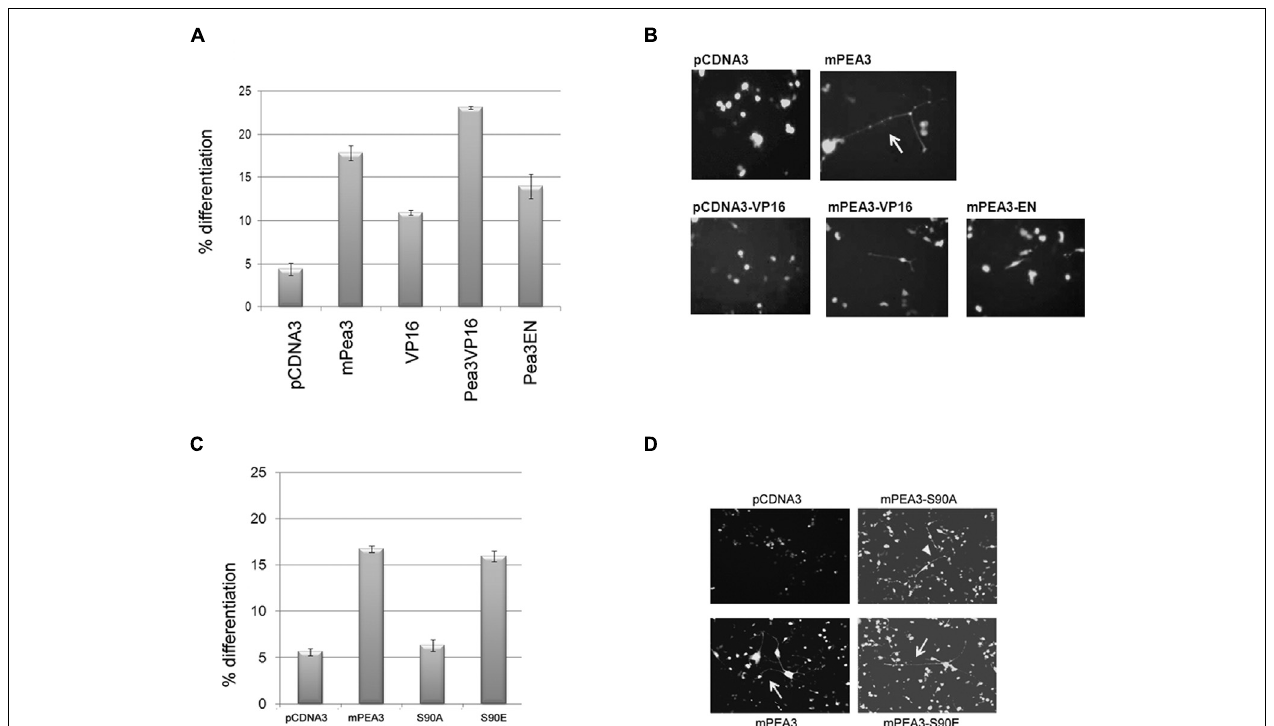
differentiation by Pea3 phosphorylation mutants as scored by the number of green fluorescent cells with axonal outgrowth longer than two cell body length versus total GFP-expressing cells (two sets of duplicates are shown, at least four different fields are scored per well); (D) representative images of NSC-34 cells transfected with either empty pCDNA3 vector, wildtype pCDNA3-mPea3, or the phosphorylation mutants pCDNA3-mPea3-S90A,